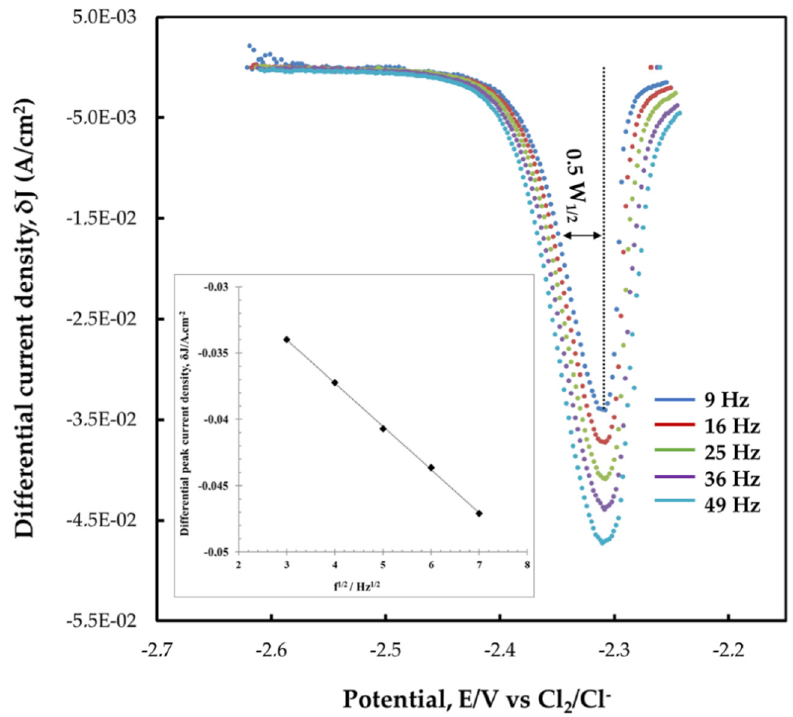
Figure 3. Square wave voltammograms on a tungsten electrode (0.12 cm 2 ) in LiCl-LiF-TiF 3 (7.25 × 10 − 2 mol · kg − 1 ) at 853 K under various frequencies. Insert linear relationship of Ti 3+ peak current density versus square root of frequency.